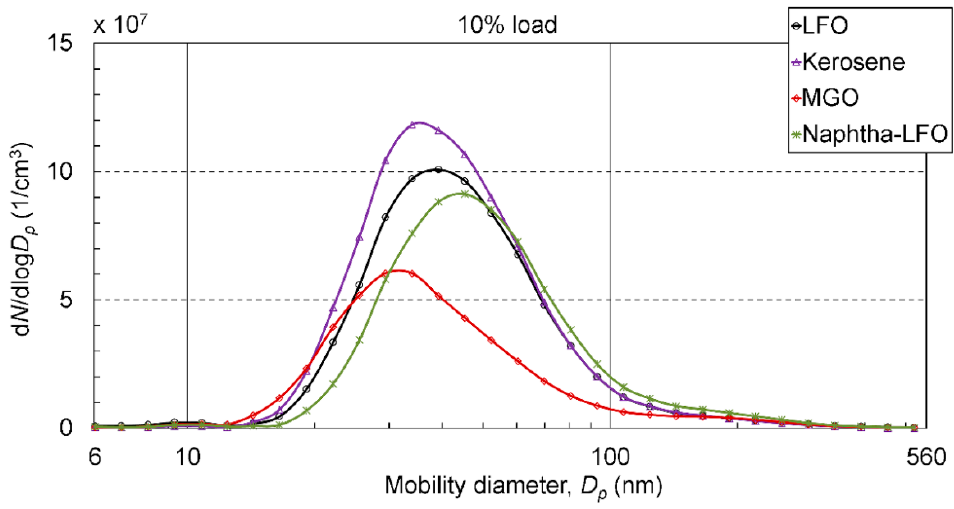
Figure 6. Exhaust PSDs at 10% load.